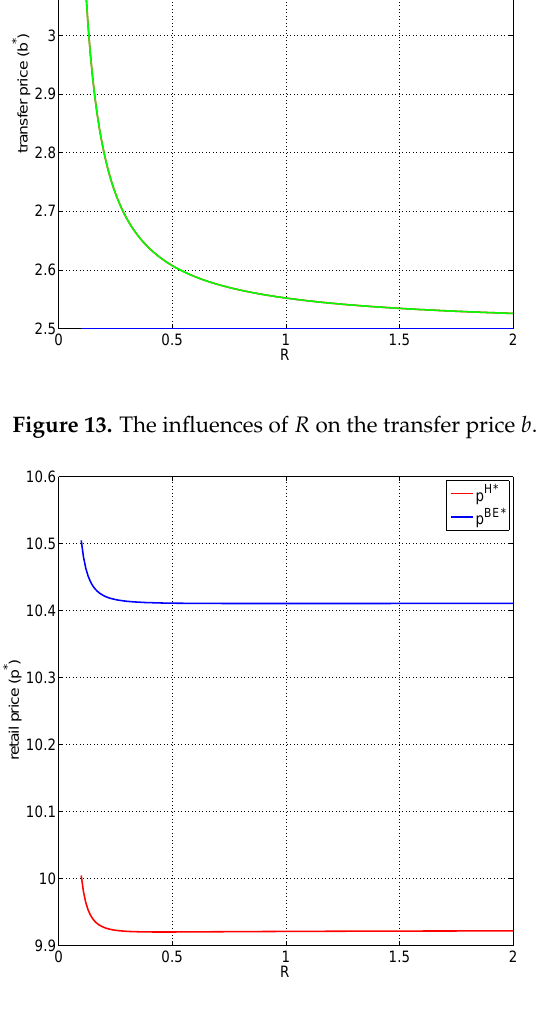
Figure 14. The influences of R on the retail price p